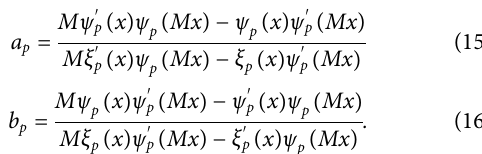
FIGURE 1 | Cylindrical waveguide coordinate system (CWG). The natural coordinate system of the waveguide is r ʺ and a point r at which we perform a partial wave expansion (PWE) in vector spherical wave functions (VSWF). In the new system, the expansion is done in the r ʹ coordinate system, the fi elds are described by the Hansen multipoles and the G TE/TM coef fi cients, that are constant in the r ʹ frame, but varies depending on the position of the expansion